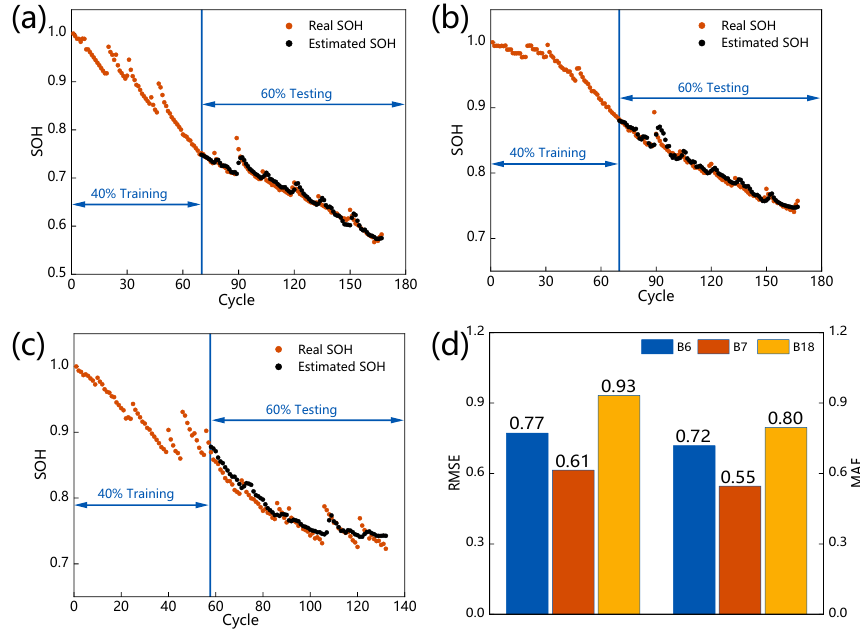
Figure 6. Results on NASA battery based on collaborative features: ( a ) B6; ( b ) B7; ( c ) B18; ( d ) MAE and RMSE analyses.